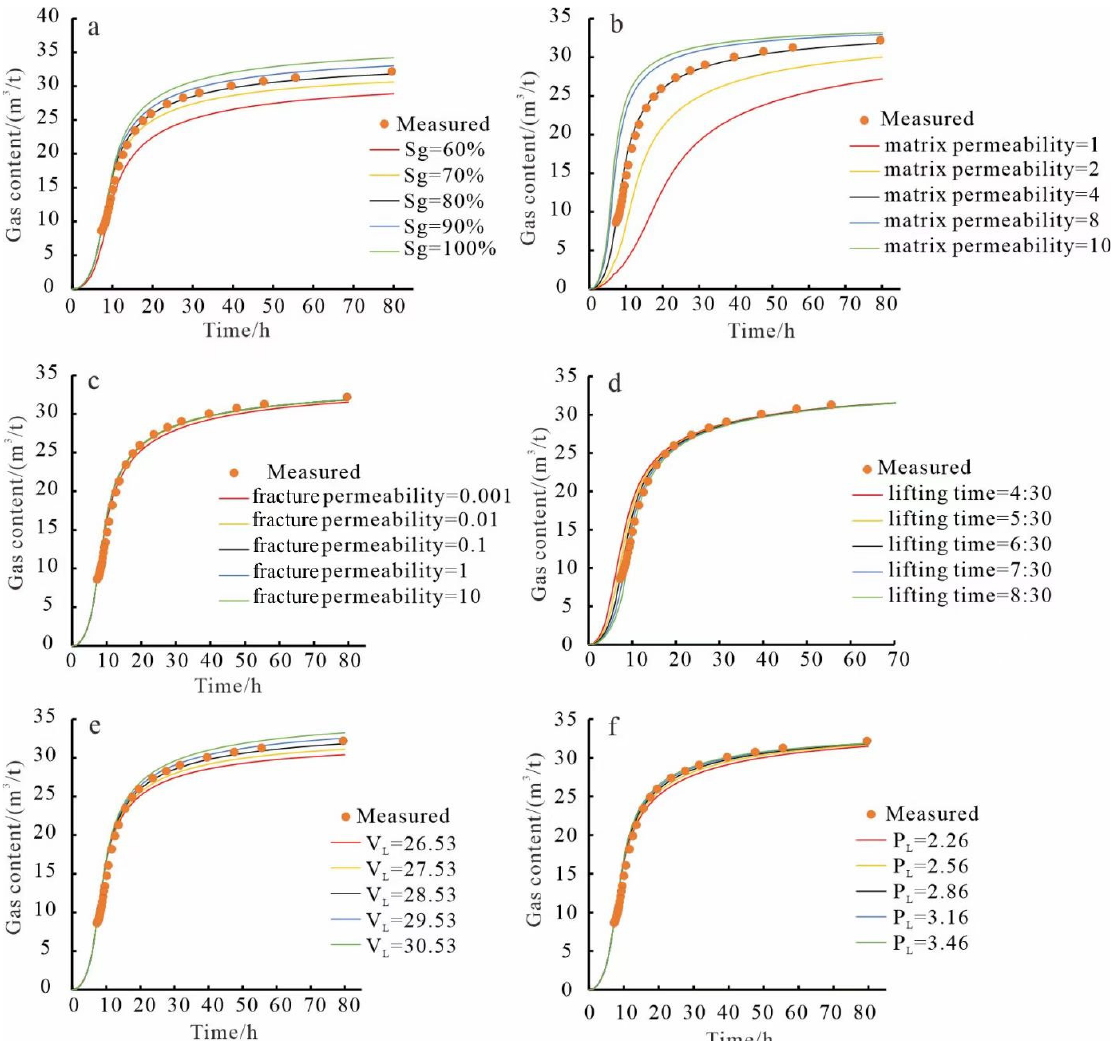
Figure 8. Sensitivity Analysis of the Factors Influencing Gas Loss (( a ): initial gas saturation; ( b ): matrix permeability; ( c ): fracture permeability; ( d ): lifting time; ( e ): Langmuir volume; ( f ): Langmuir pressure).